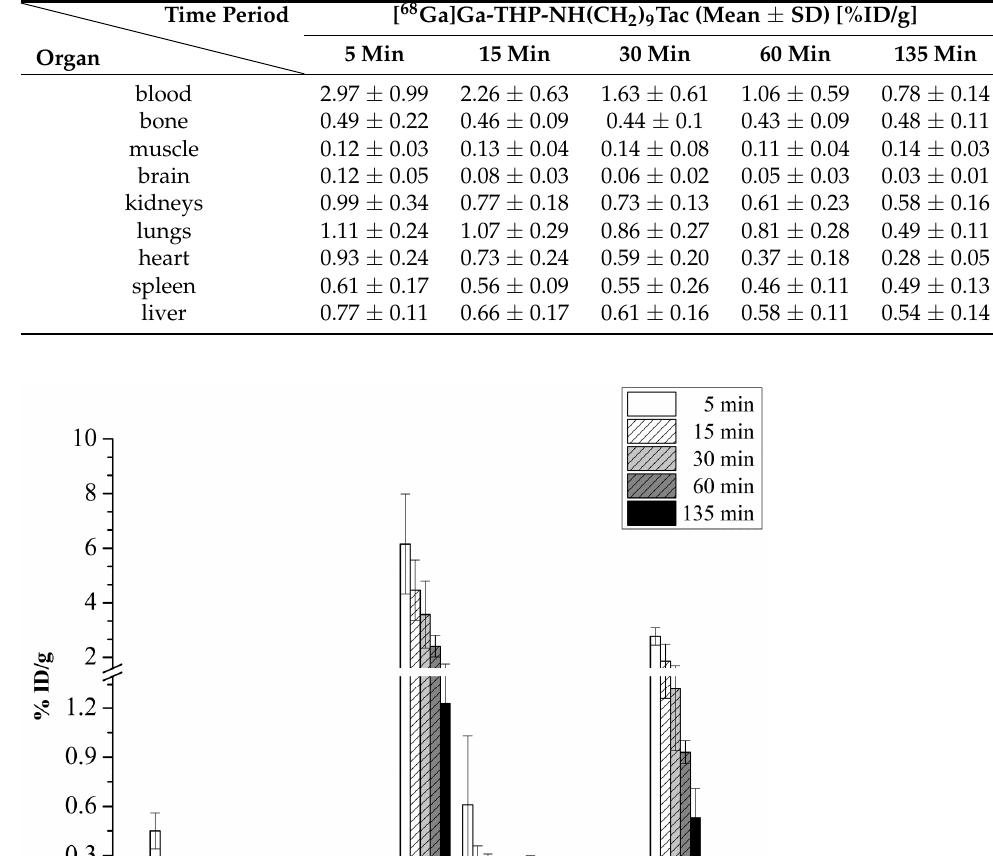
Table 2. [ 68 Ga]Ga ‐ NODAGA ‐ Bn ‐ NH(CH 2 ) 9 Tac uptake in selected rat organs determined after dif ‐ ferent time periods by ex vivo radioactivity measurements.